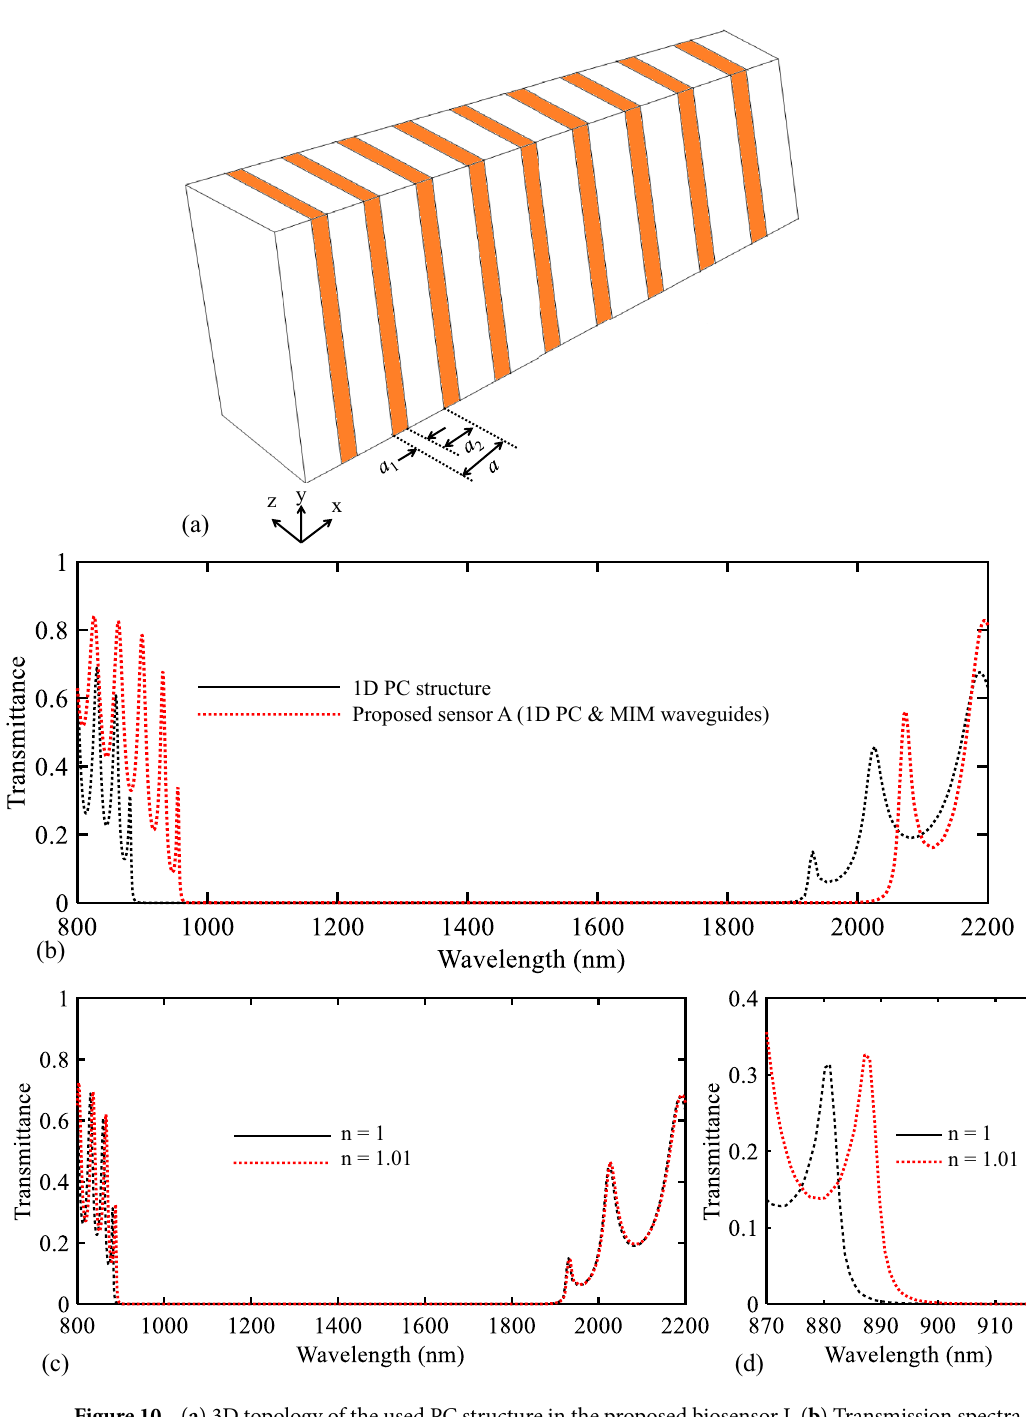
Figure 10. ( a ) 3D topology of the used PC structure in the proposed biosensor I. ( b ) Transmission spectra of the PC structure and biosensor I. ( c , d ) Transmission spectra of the proposed biosensor I for n = 1 and n = 1.01 in different wavelength